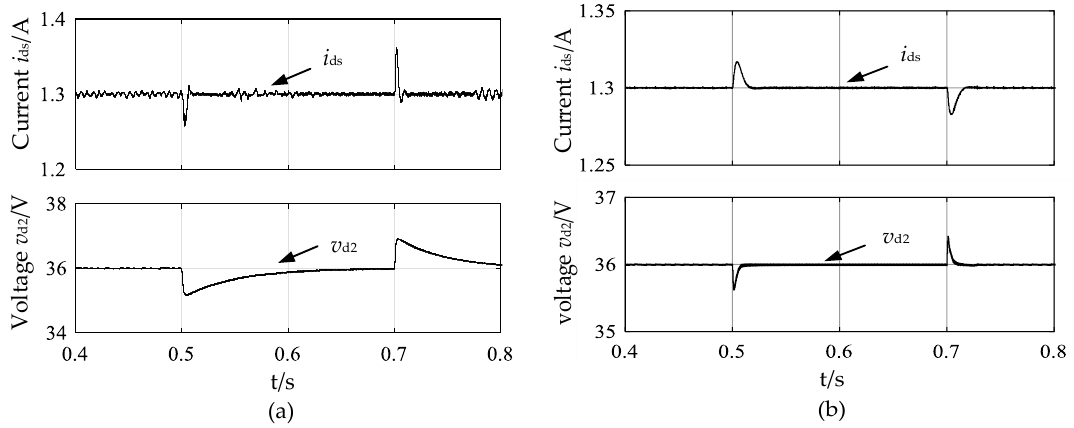
Figure 5. The simulation results of the system: ( a ) with traditional frequency control method; ( b ) with the LADRC method.